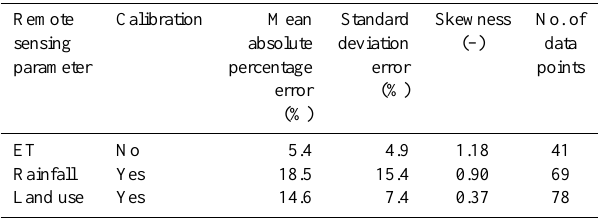
Table 2. Mean deviation of the input variables and the distribution of the